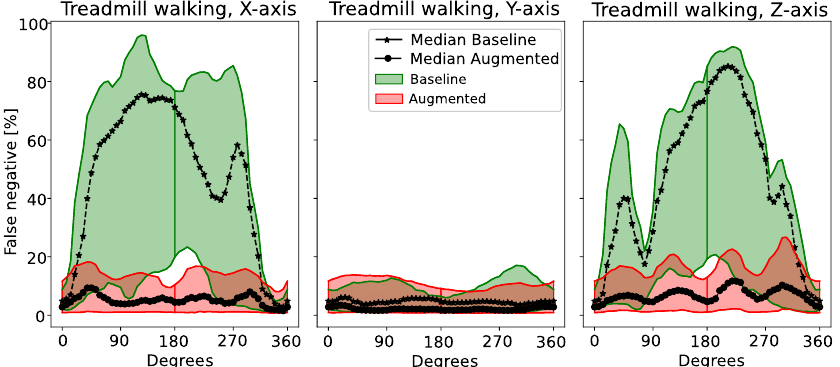
Figure 8. False negative percentage profiles of treadmill activities (i.e., walking class) for rotations applied to each axis separately for baseline and augmented models. The top line corresponds to the maximum profile for that rotation; the bottom line corresponds to the minimum profile for that rotation; the black dotted lines correspond to the profile median